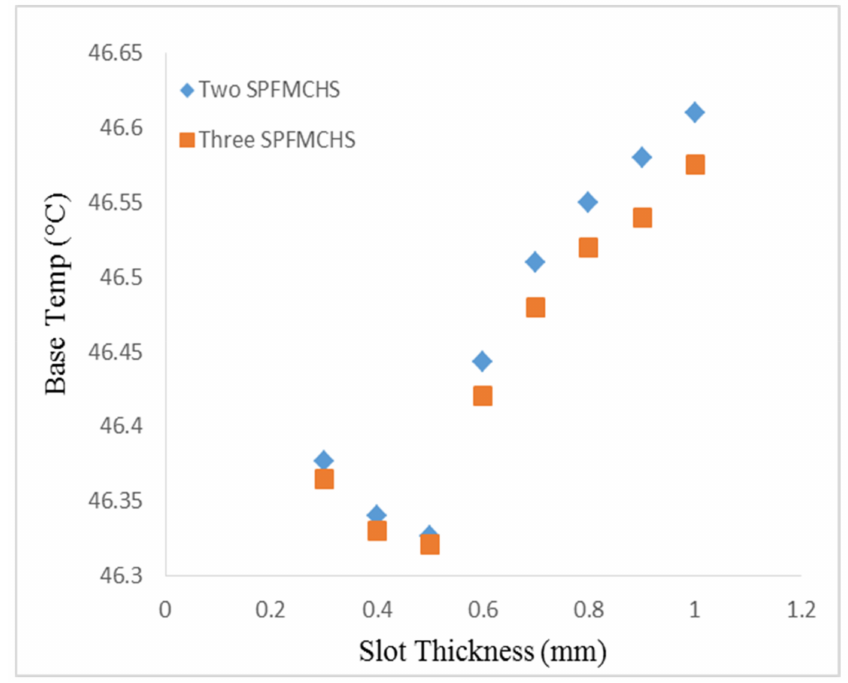
Figure 10. Base temp vs. slot